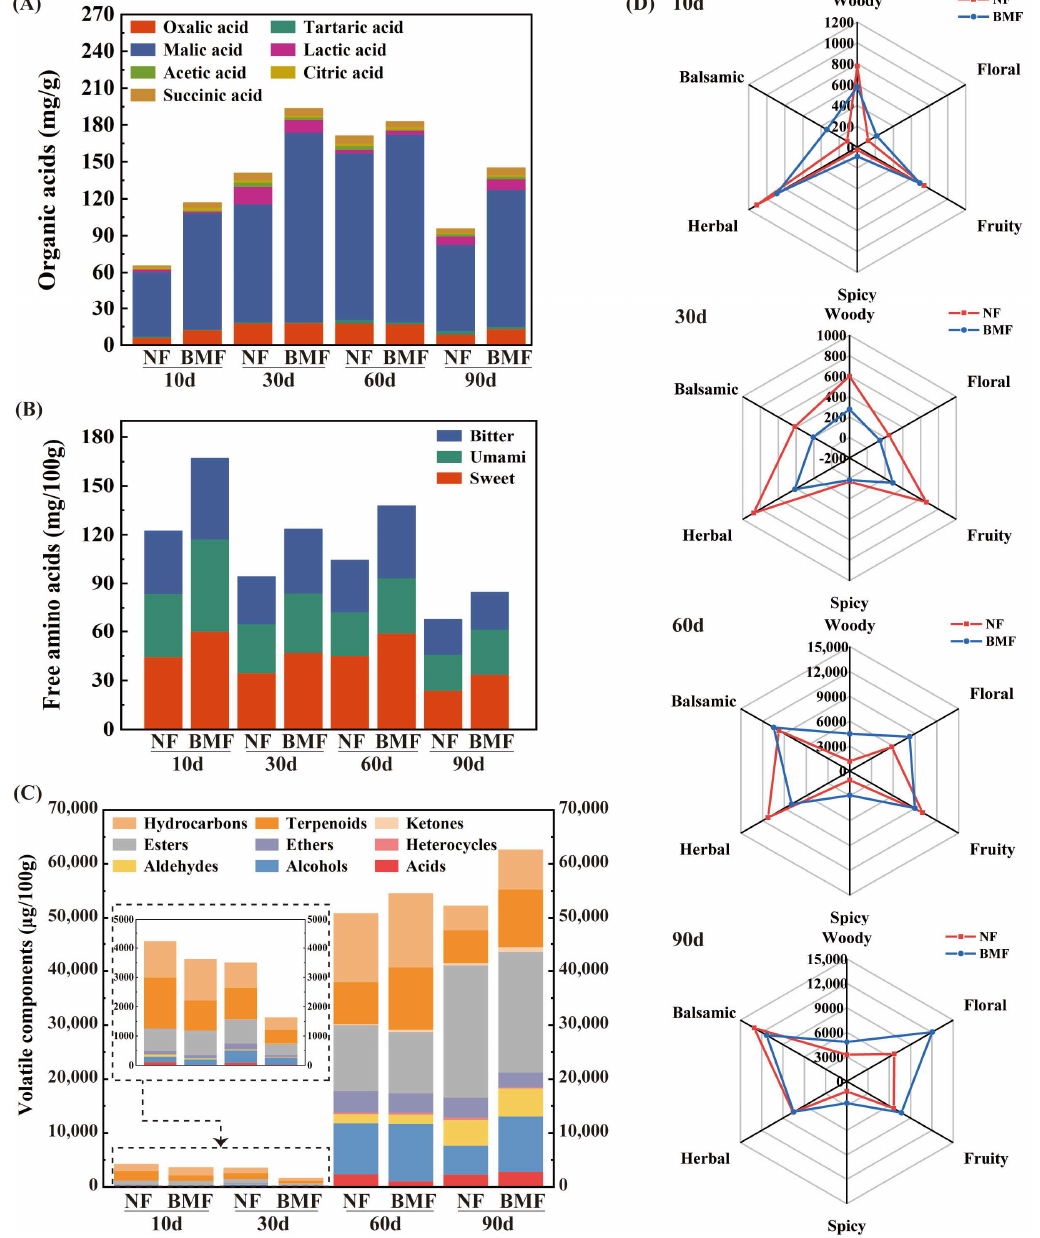
Figure 2. Changes of metabolites in NF and BMF on days 10, 30, 60, and 90 of fermentation. ( A ) Changes in OAs contents. ( B ) Changes in FAAs contents. ( C ) Changes in VCs contents. ( D ) Aroma profiles of NF and BMF based on the odorants of VCs.